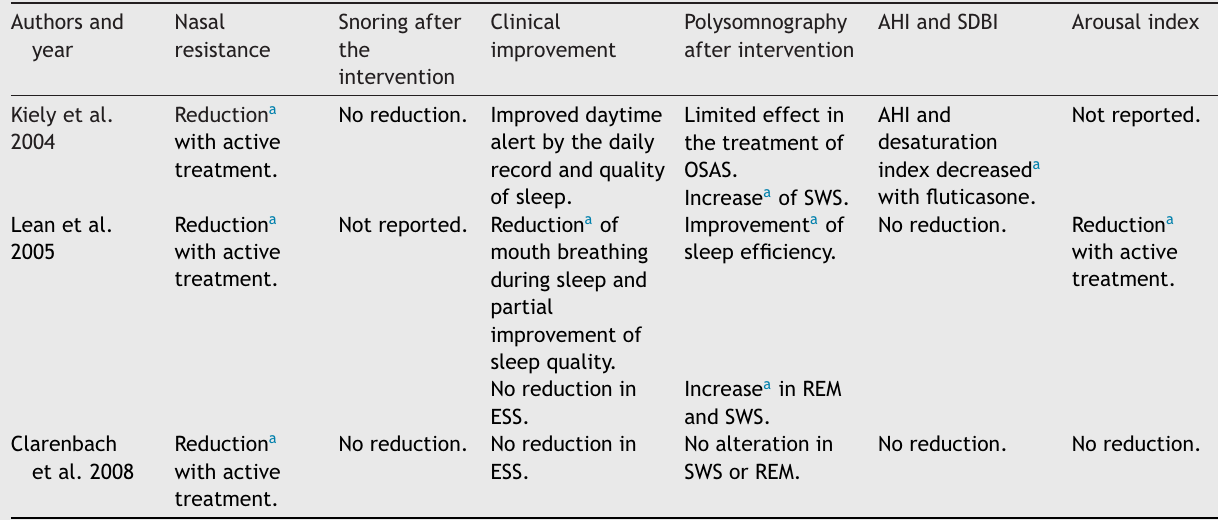
Changes with clinical